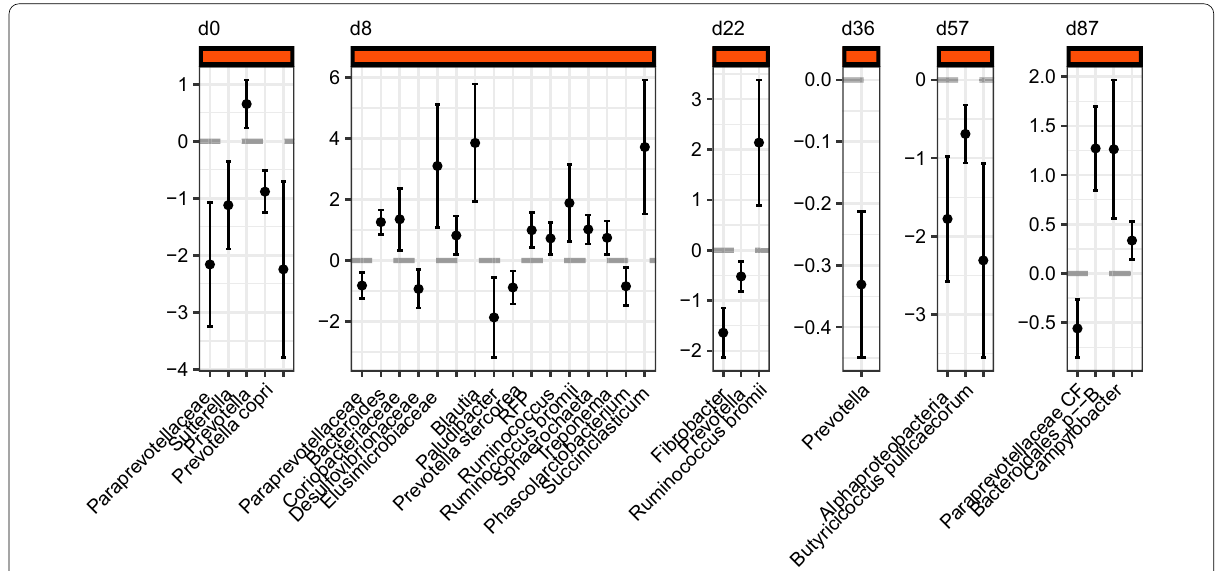
Fig. 4 Differentially abundant taxa. The estimates of the beta-binomial regression on the porcine faecal microbiomes along with its standard errors across d0–d87 PW; the positive estimates (above the grey dashed line, “0”) indicate the taxa that are more predominant in the yeast group (YL in the text) compared with those of the controls (CL). Some differentially abundant ASVs are not printed on the X-axis due to taxonomic ambiguity